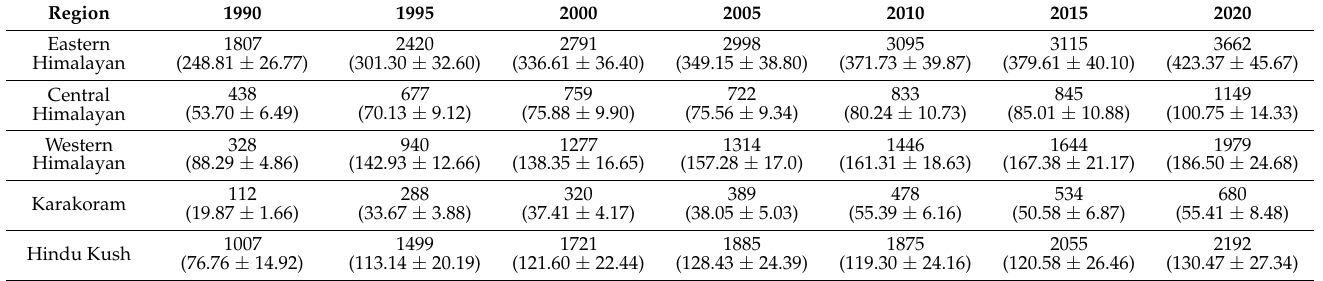
Table 3. Number and area (km 2 ) of glacial lakes in five mountain ranges from 1990 to